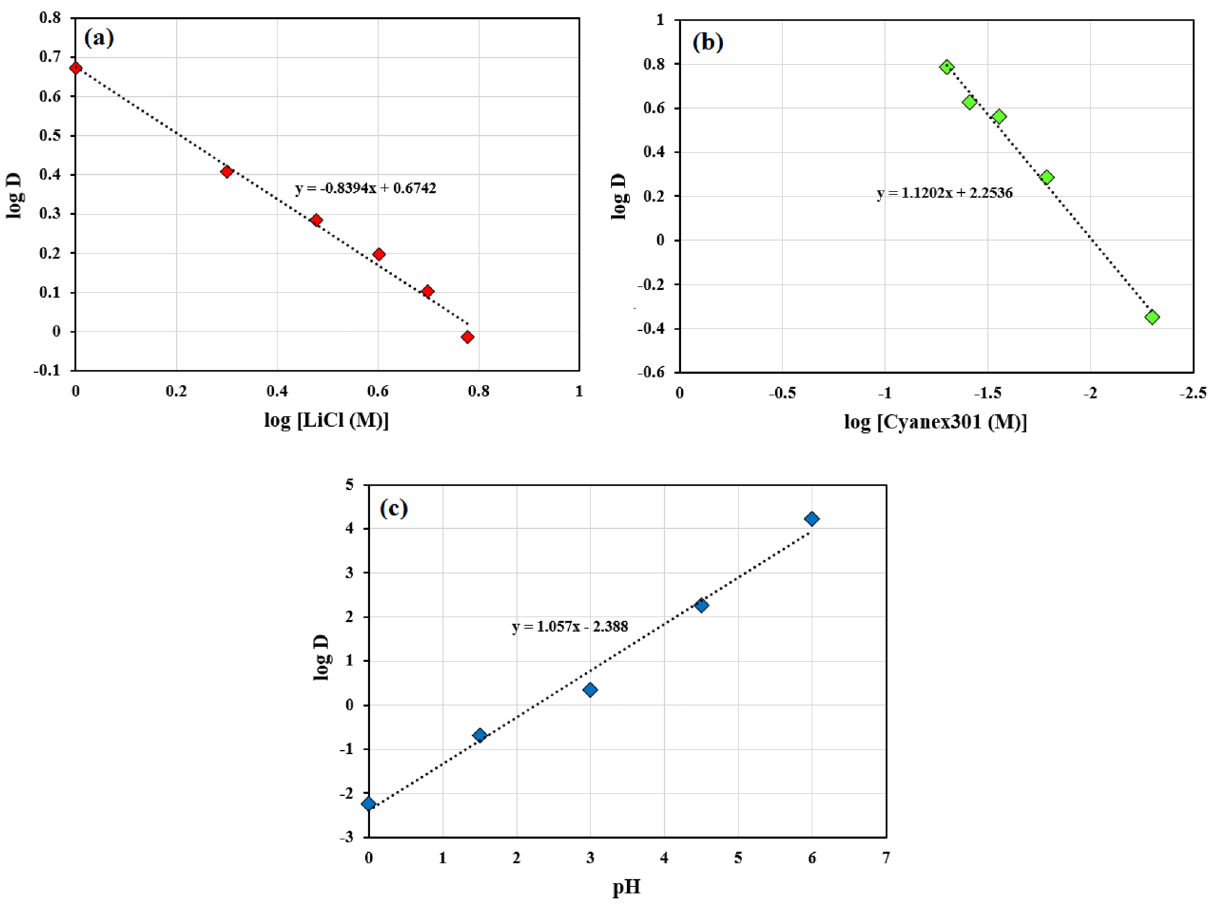
Figure 8. Effect of [LiCl (M)] concentration, Cyanex301 (M) concentration and aqueous pH on the distribution ratio under optimum condition (80% EG; T = 25 °C; time = 10 min; Co(II) = 800 ppm).